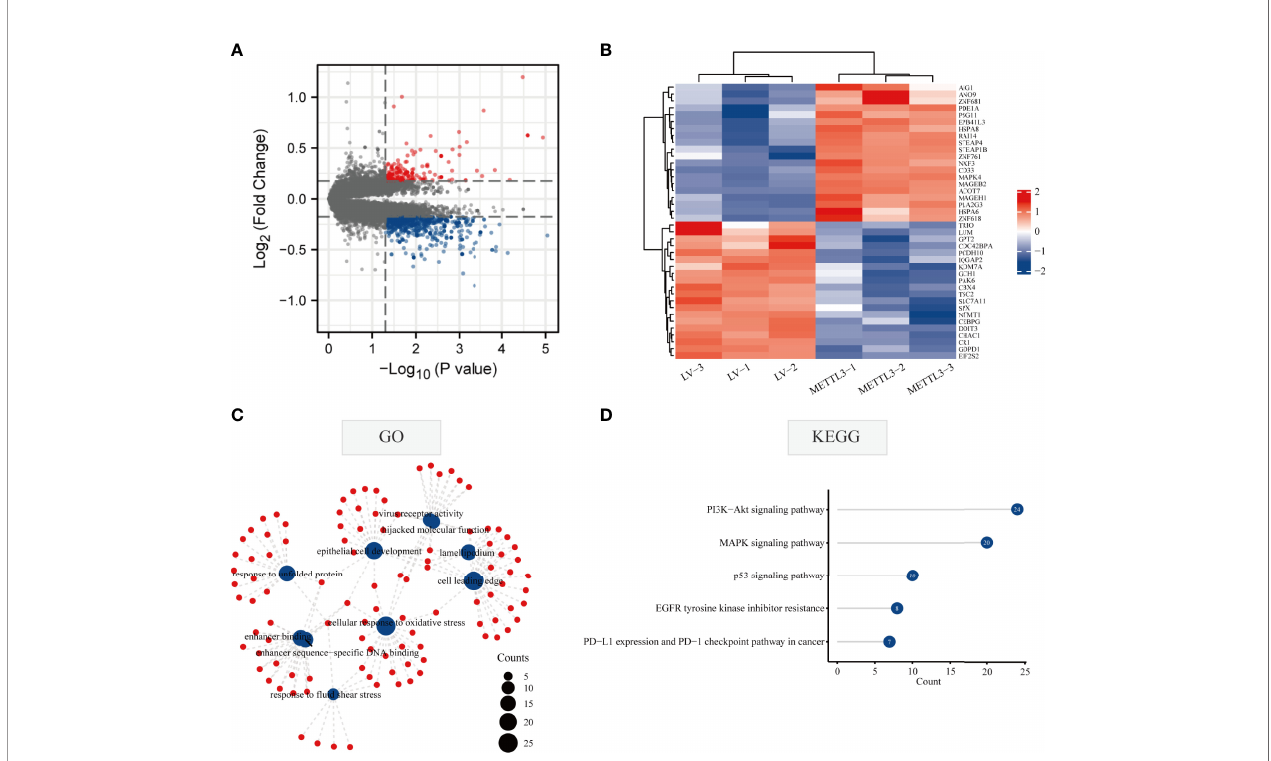
FIGURE 2 | Methylation modi fi cation of METTL3 regulatory targets. (A) Volcano plot of the methylation level of differential genes regulated by METTL3. The red and blue dots in the plot represent high and low m6A methylation modi fi cation genes, respectively. Black spots represent genes with no difference in methylation levels regulated by METTL3. (B) The top 20 genes with the highest or lowest difference in methylation levels regulated byMETTL3 were shown in the heatmap. (C, D) GO and KEGG enrichment analysis of genes with different methylation Table 1 ). These results indicated that m 6 A modi fi cation